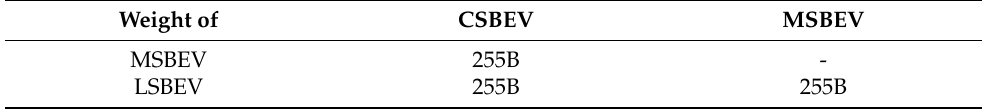
Table A3. Experiment design weight